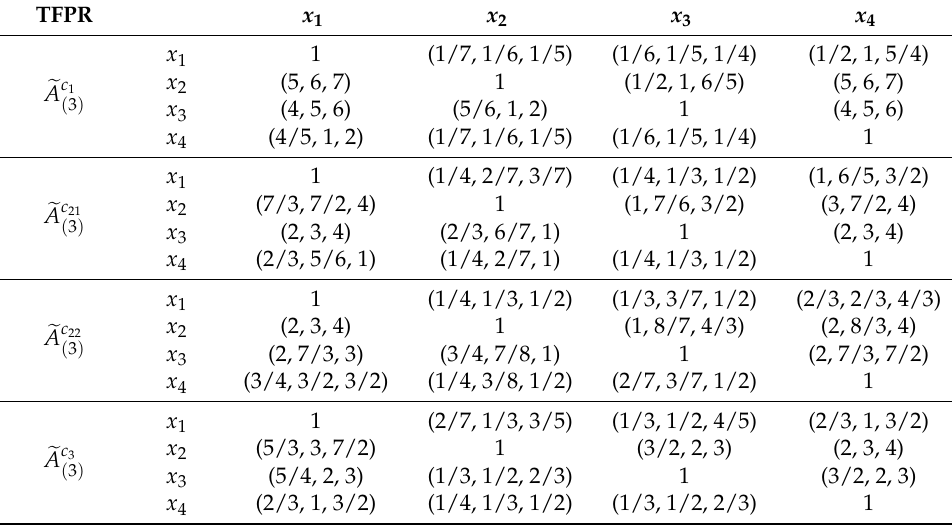
Table 4. Triangular fuzzy judgments provided by the expert e 3